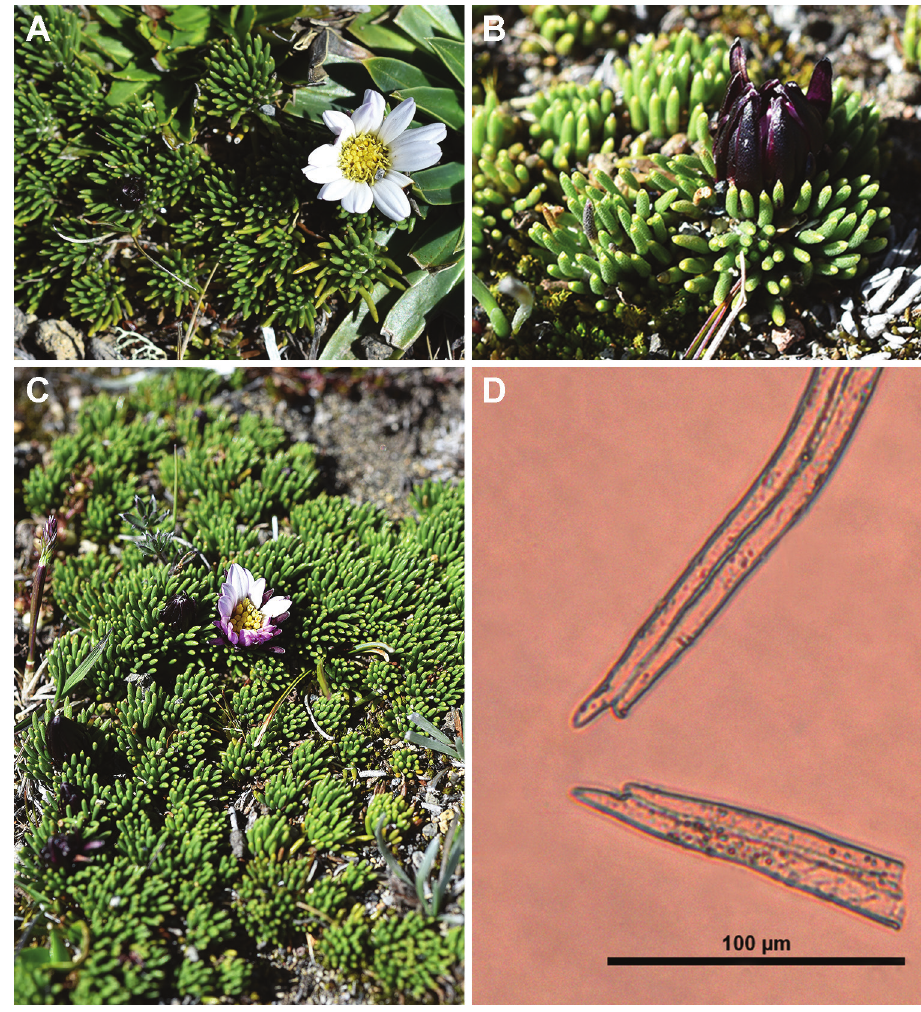
Figure 2. Xenophyllum funkianum A capitulum B involucre and leaves C habit D apex of achene tri- chomes (20× Standard 16WL); material taken from Funk & Bonifacino 14059